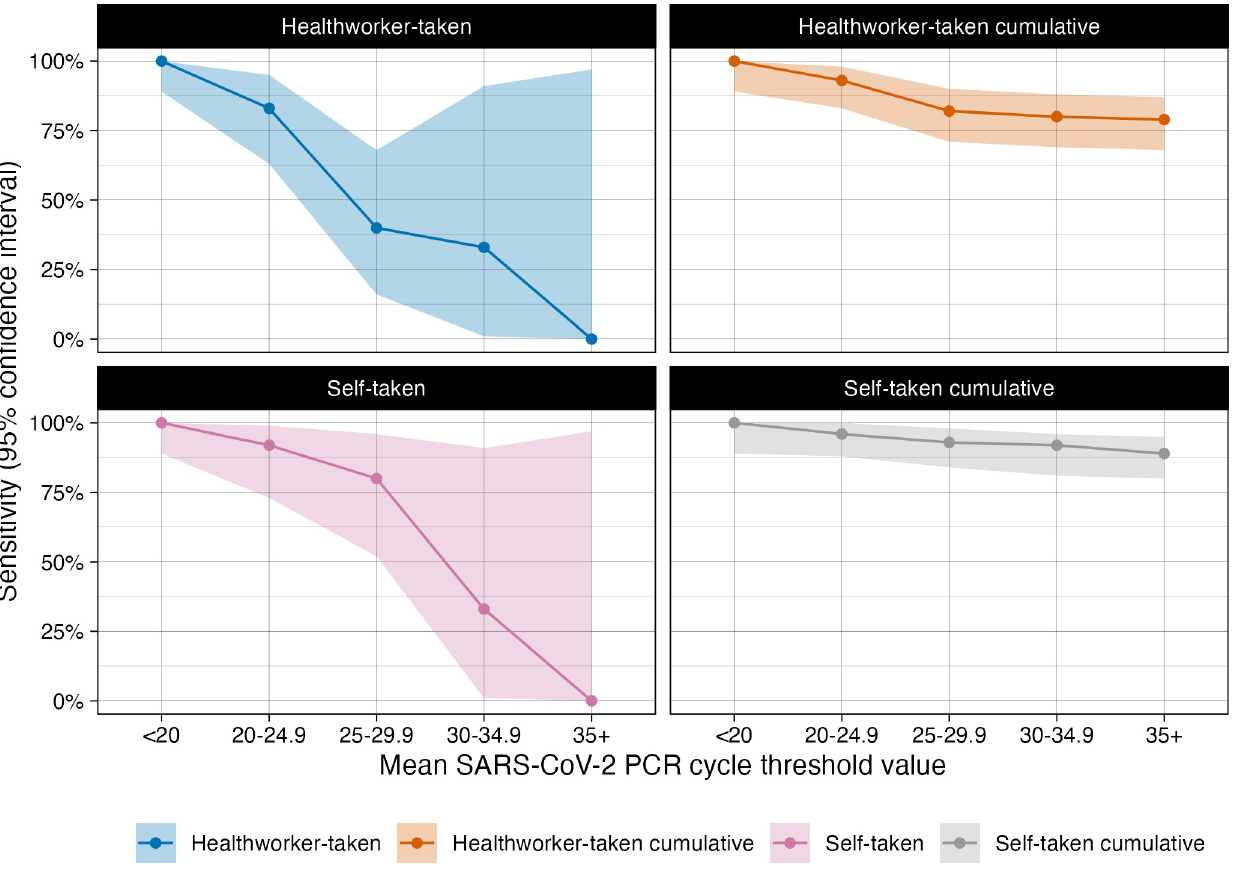
Fig 2. A graph to show the sensitivity of the Covios 1 SARS-CoV-2 RDT by mean CT range and cumulative sensitivities.